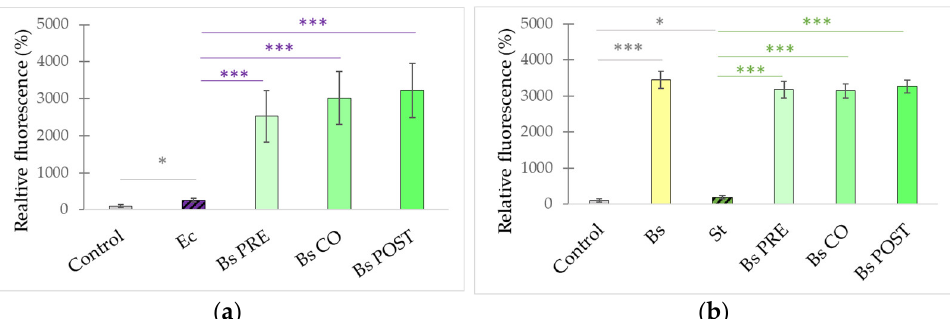
Figure 3. Effect of B. subtilis on the paracellular permeability of IPEC-J2 cells treated with E. coli ( a ) and S. Typhimurium ( b ), respectively. B. subtilis was added 1 h before (pre-treatment), at the same time as (co-treatment), and 1 h after (post-treatment) the addition of S. Typhimurium or E. coli , respectively. Detection of the FD4 dye was performed 24 h after the treatment of S. Typhimurium or E. coli, respectively. Control : plain cell culture medium treatment; Ec : E. coli 10 6 CFU/mL; St : S. Typhimurium 10 6 CFU/mL; Bs : treatment with B. subtilis 10 8 CFU/mL; Bs PRE : pre-treatment with B. subtilis 10 8 CFU/mL + E. coli 10 6 or S. Typhimurium CFU/mL; Bs CO : co-treatment with B. subtilis 10 8 CFU/mL + E. coli or S. Typhimurium 10 6 CFU/mL; Bs POST : post-treatment with B. subtilis 10 8 CFU/mL + E. coli or S. Typhimurium 10 6 CFU/mL. Data are shown as means with standard deviations and expressed as relative fluorescence, considering the mean value of control as 100%. n = 6/group. Significant difference: * p ≤ 0.05,*** p ≤ 0.0001, in grey: compared with the untreated control. *** p ≤ 0.0001, in green: compared with treatment with S. Typhimurium, *** p ≤ 0.0001, in purple: compared with treatment with E. coli.